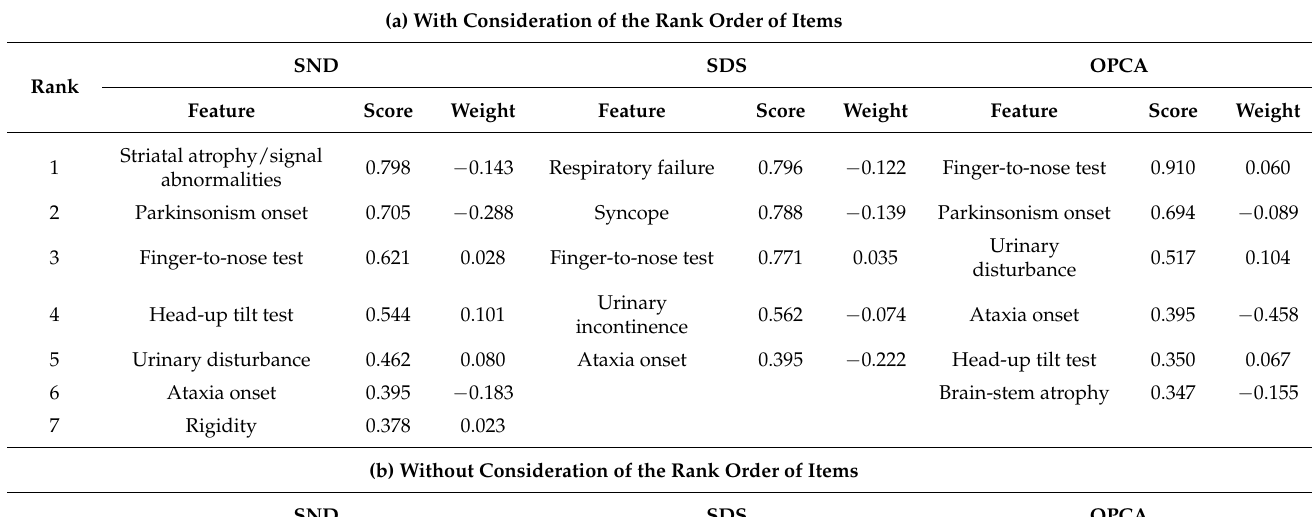
Table 6. Features involved in diagnosis of MSA using the pointwise linear